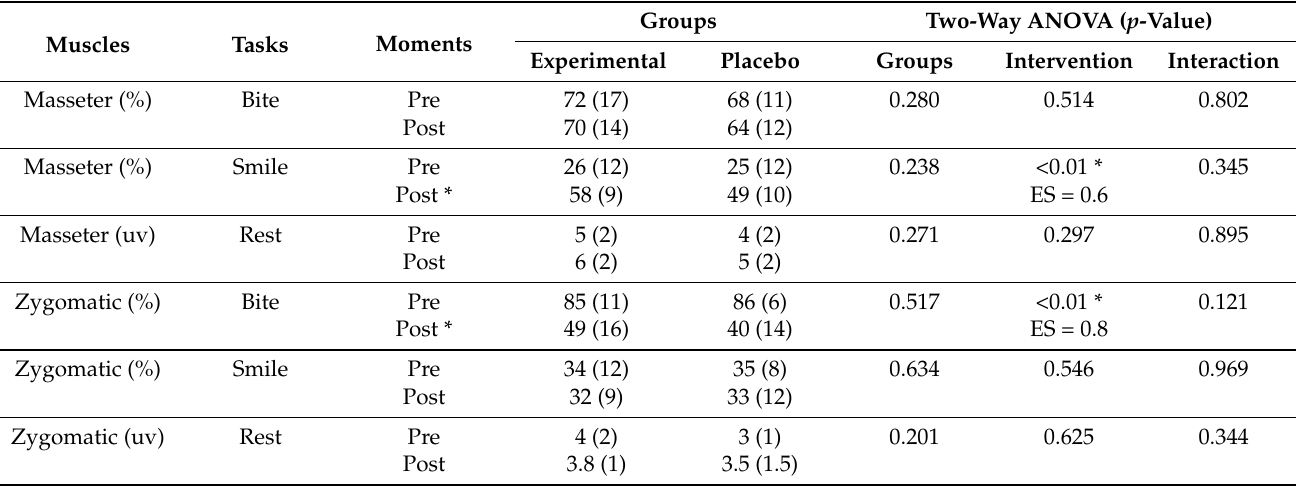
Table 2. Muscle activation (EMG %) during three facial tasks (rest, smile and bite) before and after intervention.